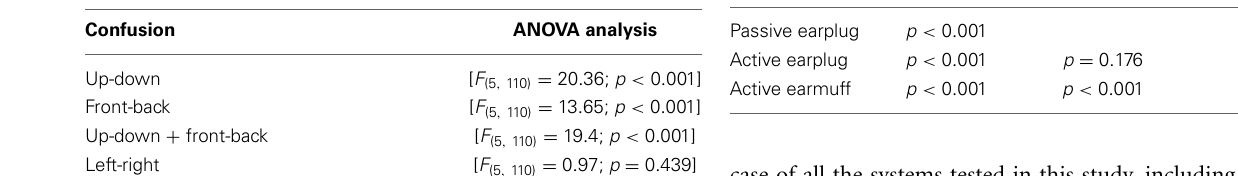
FIGURE 4 | Mean number of confusions (for one session of 80 sounds) for each test condition. The different types of confusions are color-coded as follows. Type 1: up-down; Type 2: front-back; Type 3: combination of up-down and front-back; Type 4: combination of up-down, front-back, and left-right. Table 3 | Two-Way (test condition) repeated-measure analysis of variance (ANOVA) results for different types of confusion.